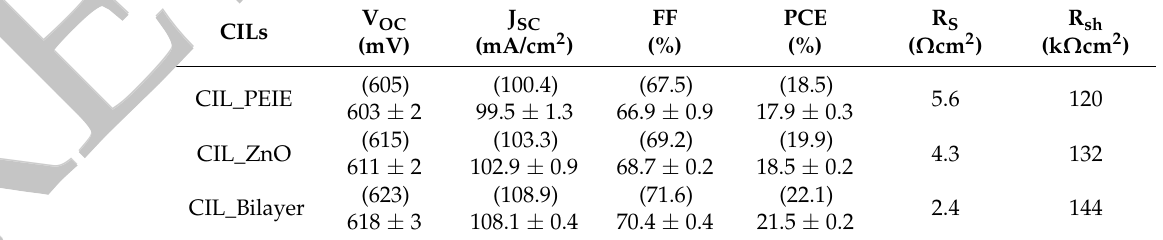
Table 2. Summary of electrical parameters of OSCs under 1000-lx LED 3000 K illumination. Values are averaged over 20 devices. The values in brackets are amongst the highest.